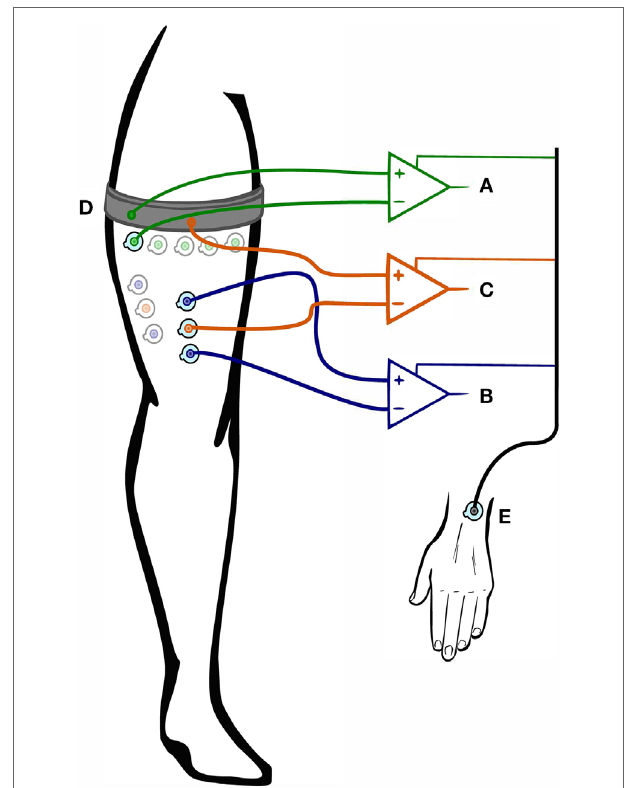
FigUre 1 | Sketch of the three electrode configurations. (a) Untargeted monopolar configuration, (B) targeted bipolar configuration, (c) targeted monopolar configuration, (D) common circumferential electrode, and (e) reference